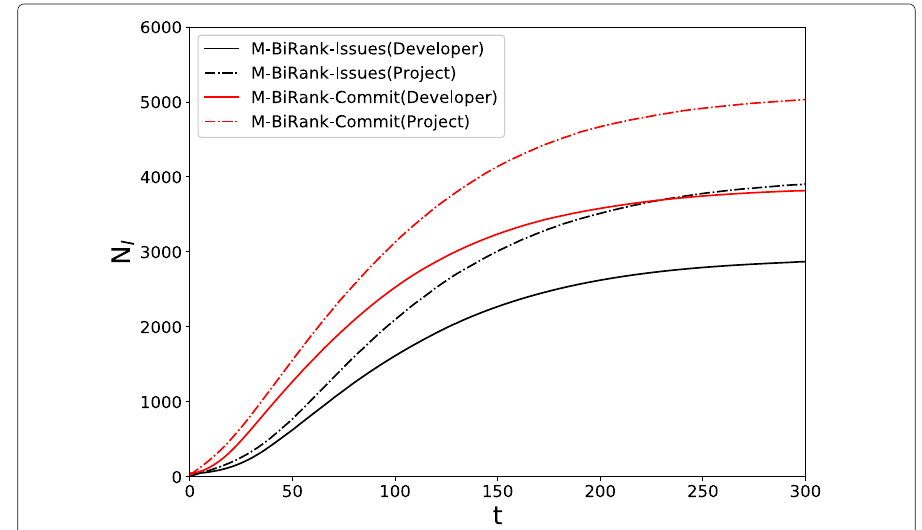
Fig. 3 Performance comparison between M-BiRank-Commit and M-BiRank-Issue. The horizontal axis t indicates the number of iterations in SIR modeling. The vertical axis N I indicates the number of final infected nodes (developers or projects, including infected and removed